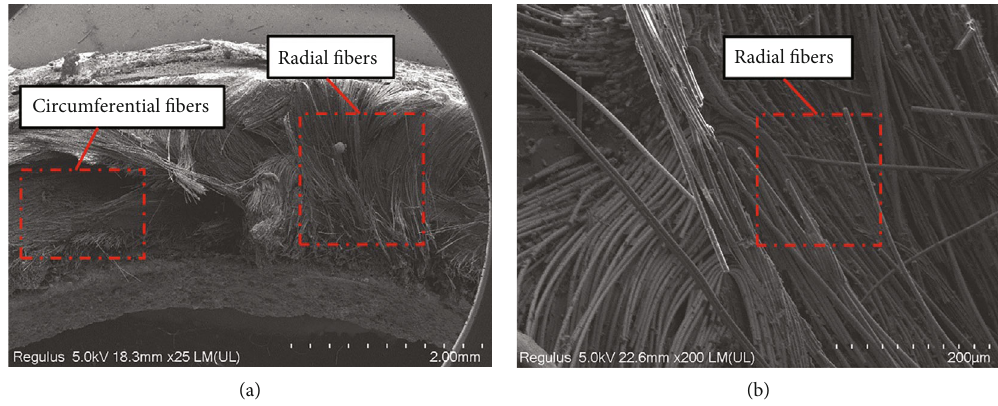
Figure 13: SEM of the crack section: (a) 2.00mm and (b) 200 μ m.